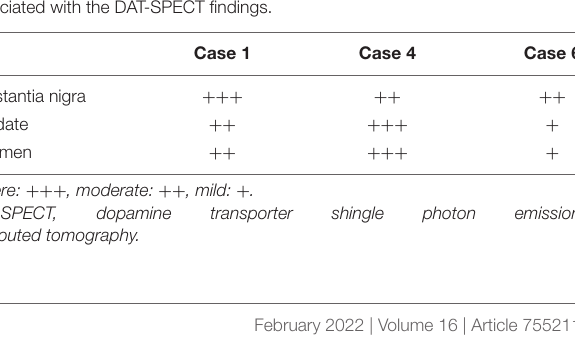
TABLE 3 | The degree of neuronal loss and astrogliosis in the brain regions associated with the DAT-SPECT